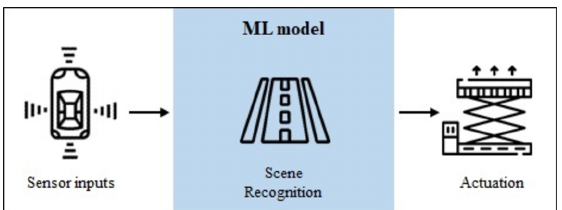
Figure 1. Simplified diagram of an autonomous vehicle operation during run time. A Machine Learning (ML) component is responsible for scene recognition